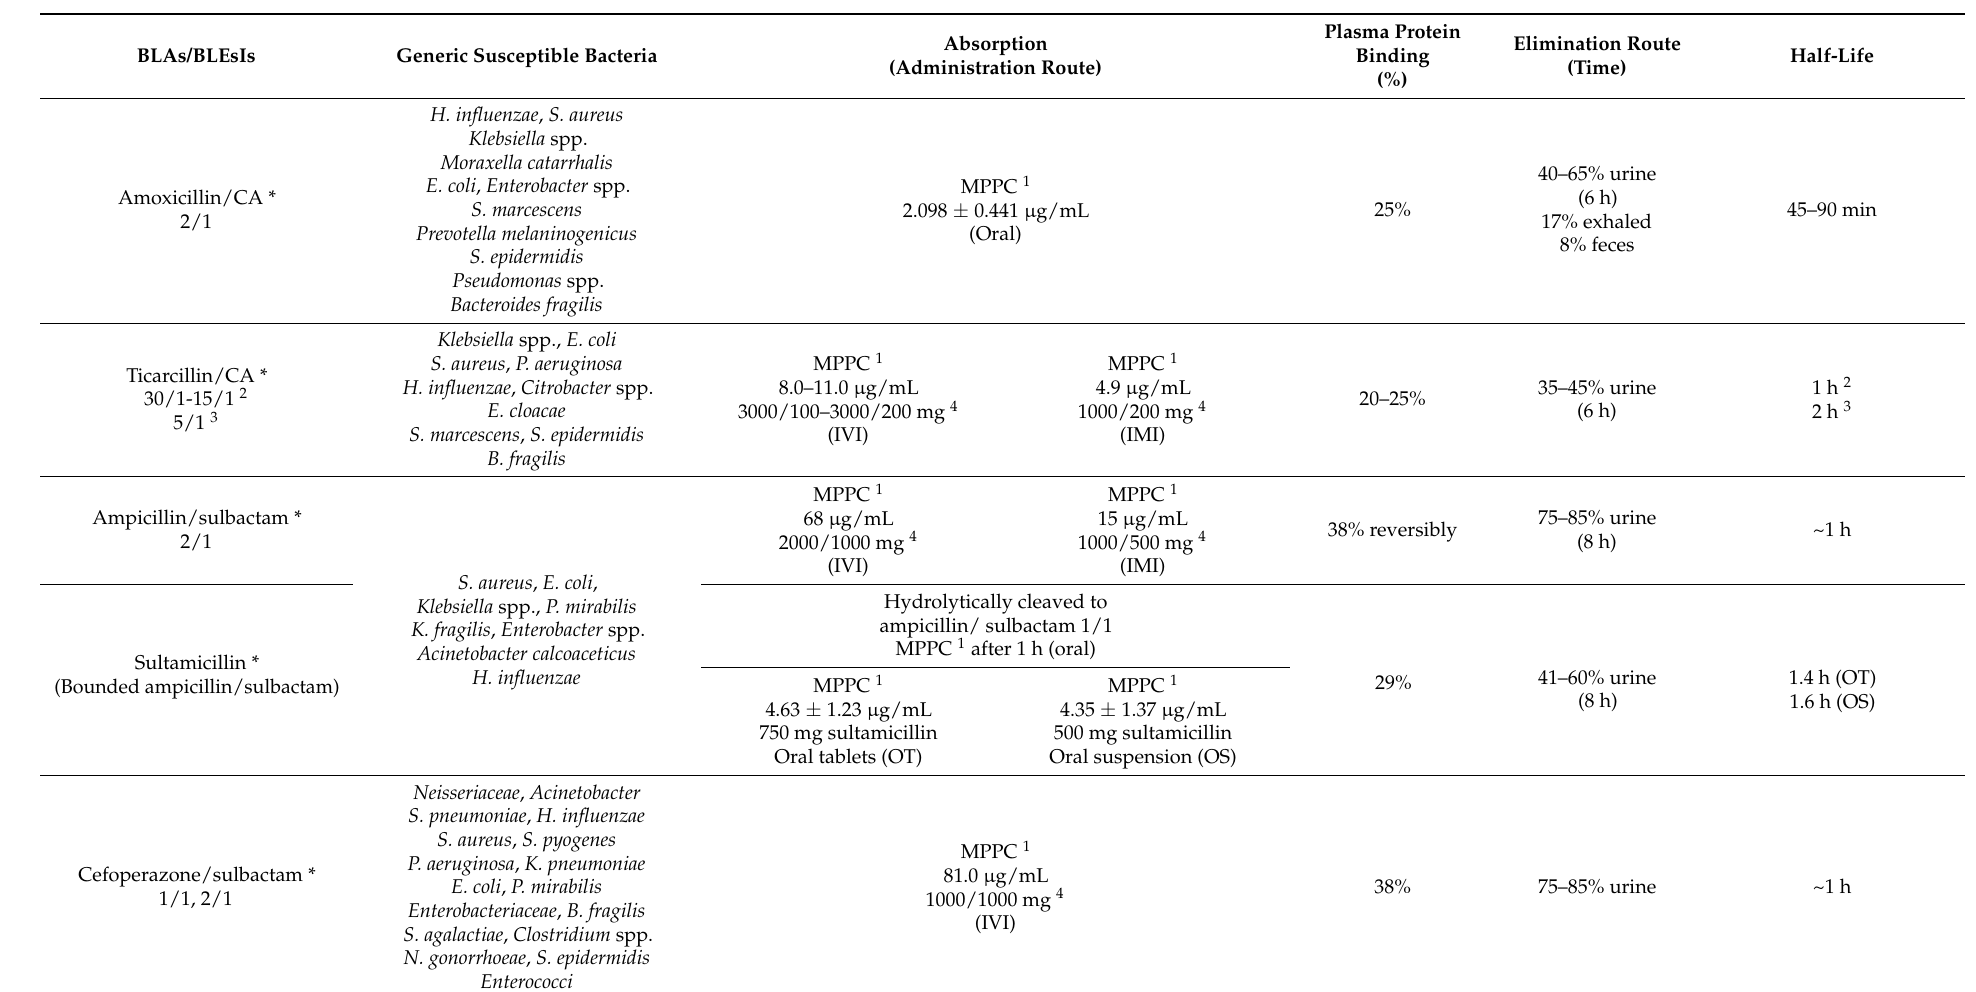
Table 4. Main BLEIs/BLAs associations, target bacteria producing BLEs, and other clinical aspects (route of administration and pharmacokinetic data). Except for those with different specifications, all numeric data refer to the reported BLEsI. The references of works used as sources of the information reported in this Table have been included in the main